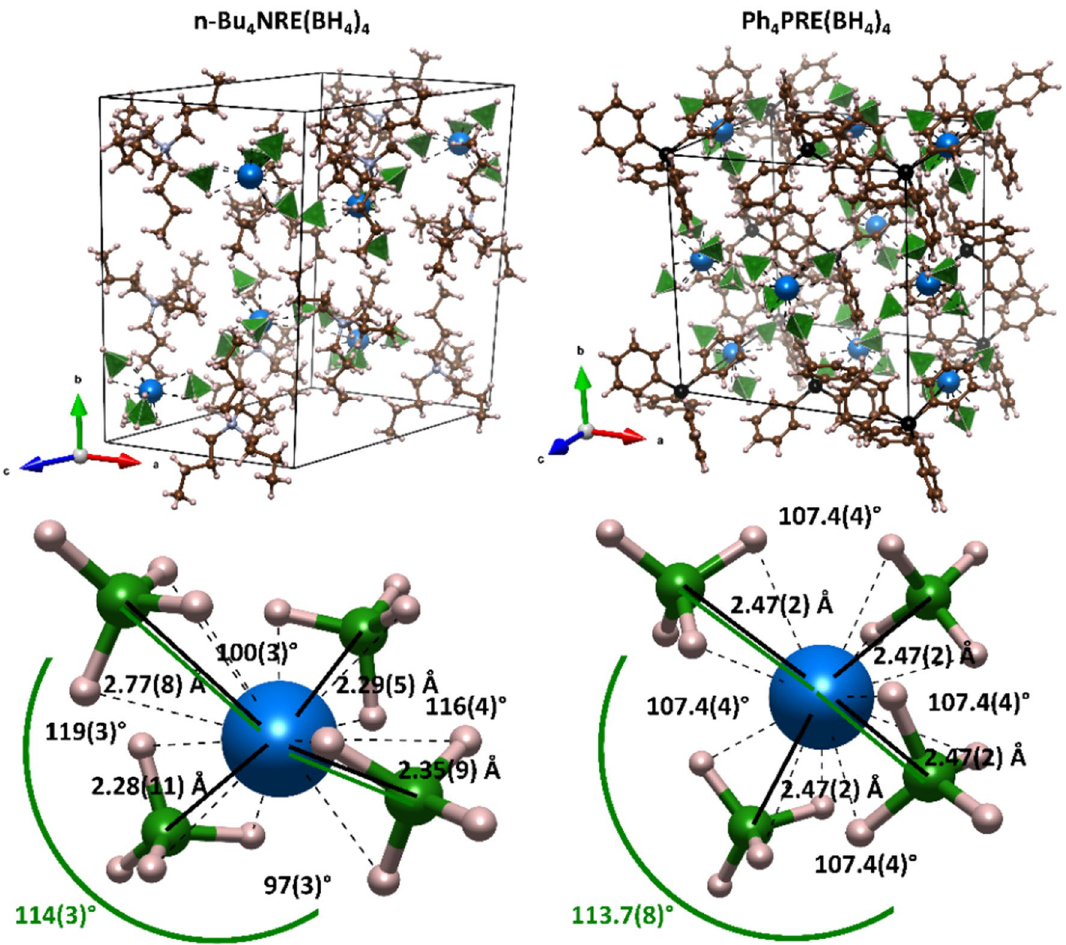
Figure 1. Crystal structures of 1 and 1@Y (left) and 2 and 2@Y (right): the unit cell contents (top) and the detailed insight into coordination environment of Dy centers (bottom). Colors: blue – RE III (Dy III ); black – P; grey – N; brown – C; pink – H; green – B and BH 4 – tetrahedron. Visualization presented for diluted